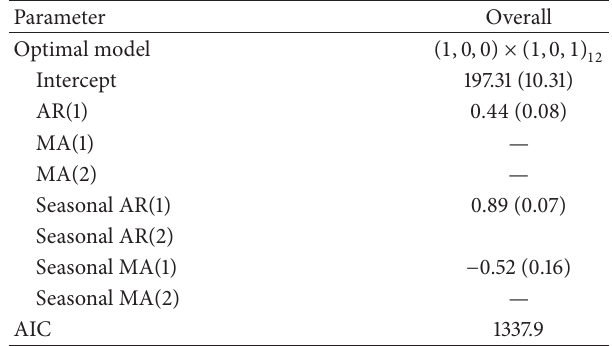
Parameter estimates are displayed with standard error in parentheses.